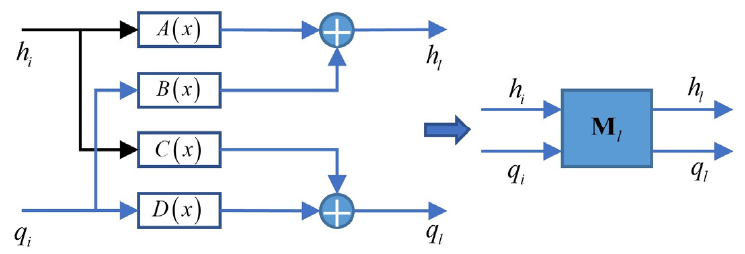
Figure 1. Single pipe four-port equivalence model.